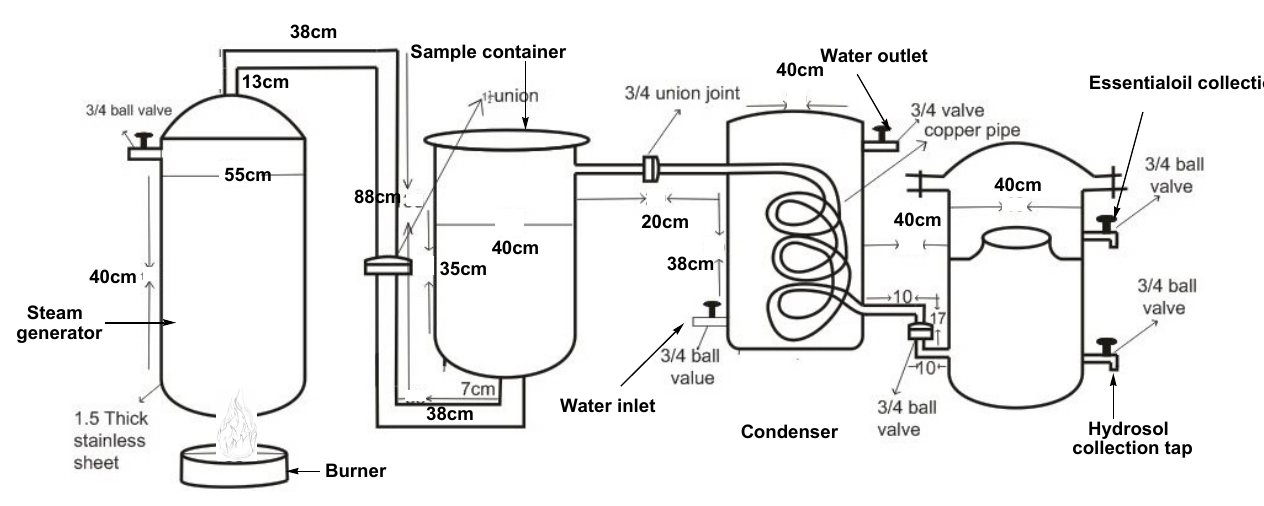
Figure 1. Schematic of the Essential oil Distillation System (EDS).